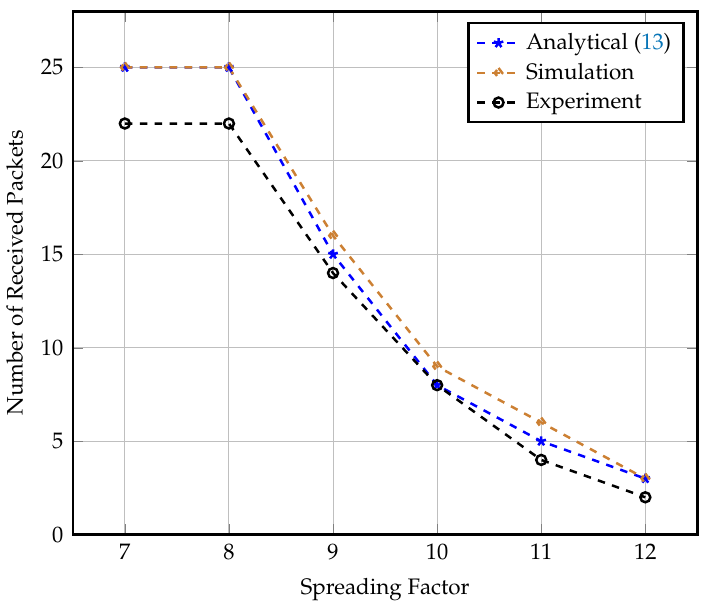
Figure 8. Number of received packets at speed = 90 km/h for different SF